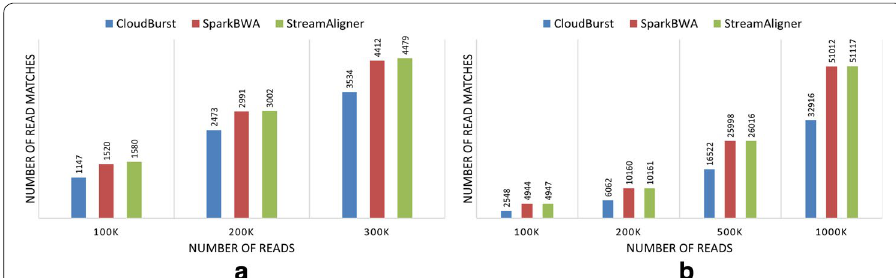
Fig. 12 StreamAligner accuracy evaluation to map ( a ) AML and ( b ) BRL query datasets on